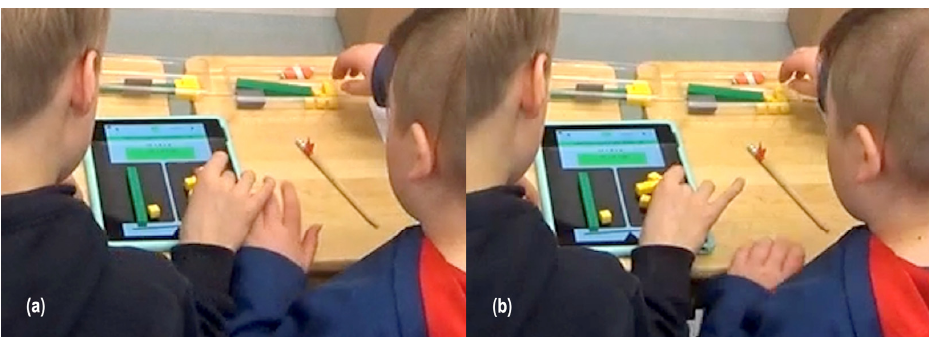
Figure 9. Dominance. ( a ) St 7 (B) (on the left) pushing St 8 (B)’s (on the right) hand away from the tablet. ( b ) St 7 (B) quickly adding base-10 blocks to the X -box to solve the equation, making it impossible for St 8 (B) to join.